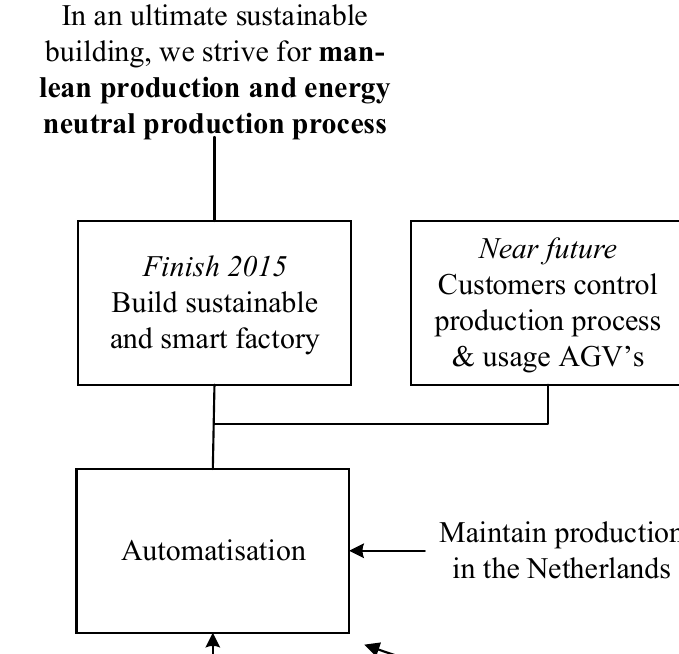
Figure A5. Flow chart for House of Blue Jeans.